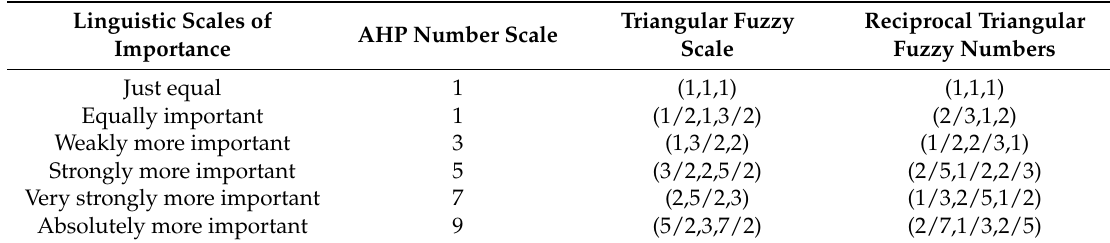
Table 5. Importance values setting of pairwise comparison for fuzzy analytic hierarchy process